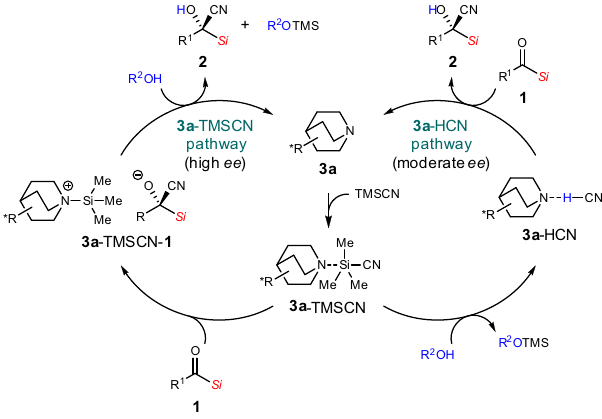
Fig. 5 Proposed catalytic pathways. A plausible mechanism consists of 3a -TMSCN and 3a -HCN